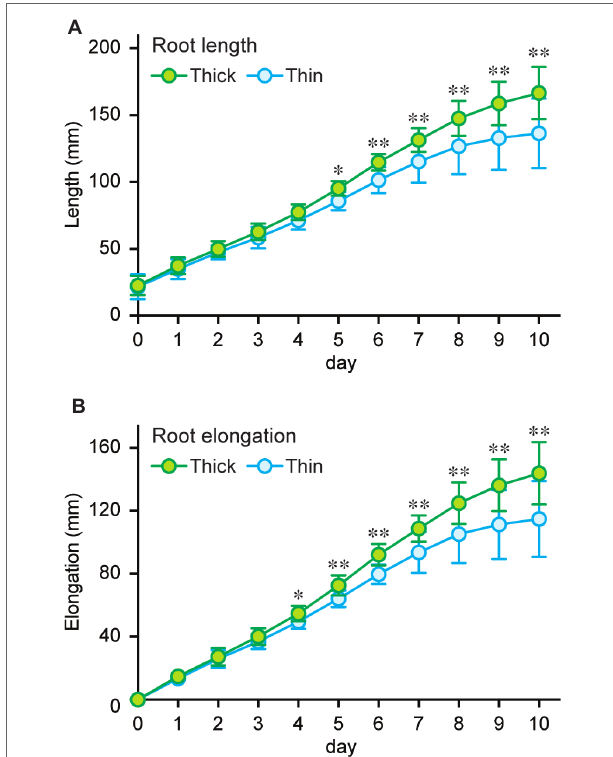
FIGURE 7 | Elongation of thick and thin adventitious roots of rice. Lengths (A) and elongation (B) of thick and thin adventitious roots of rice under stagnant conditions. Nine-day-old rice seedlings were further grown under stagnant conditions for 7 days, and lengths of thick and thin adventitious roots were measured every day on days 16–26 under stagnant conditions. Significant differences between thick and thin adventitious roots at p < 0.01 and p < 0.05 (two-sample t- test) are denoted by ∗∗ and ∗ , respectively. Values are means ± SD ( n =